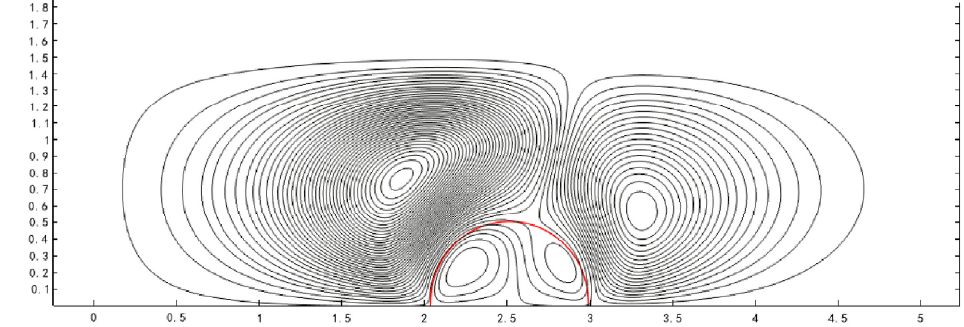
Fig. 5 Silicone-oil droplet streamlines for θ = 90° and G = 20 K/mm at t = 0.01 s.